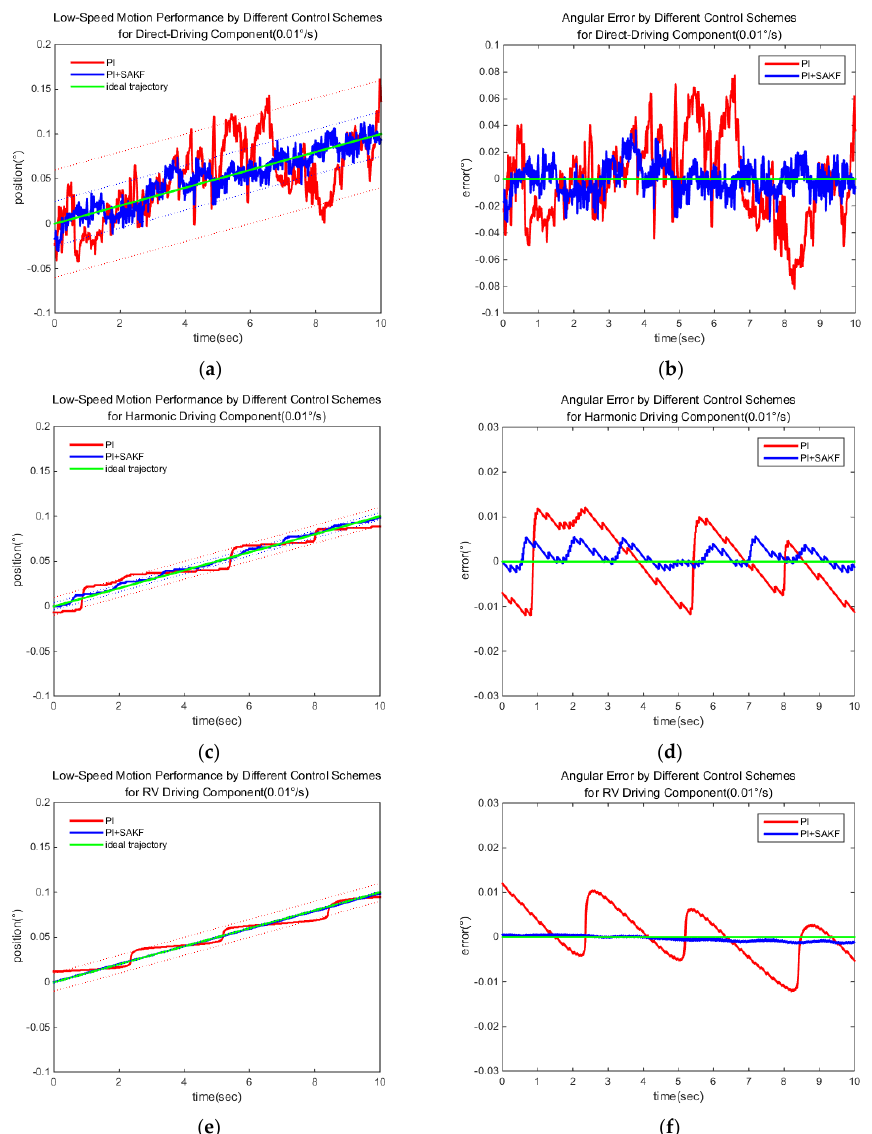
Figure 9. Measured angular position of the ( a ) direct-driving component, ( c ) harmonic-driving component, and ( e ) RV-driving component, and the calculated angular error of ( b ) the direct-driving component, ( d ) harmonic-driving component, and ( f ) RV-driving component by the PI and the PI + SAKF with the reference speed v r = 0.01°/s.